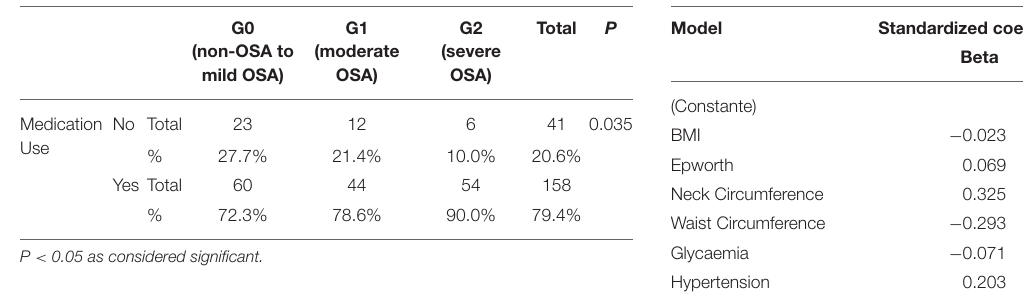
TABLE 2 | Frequency of medication use by presence and severity of OSA. TABLE 3 | Associated factors with